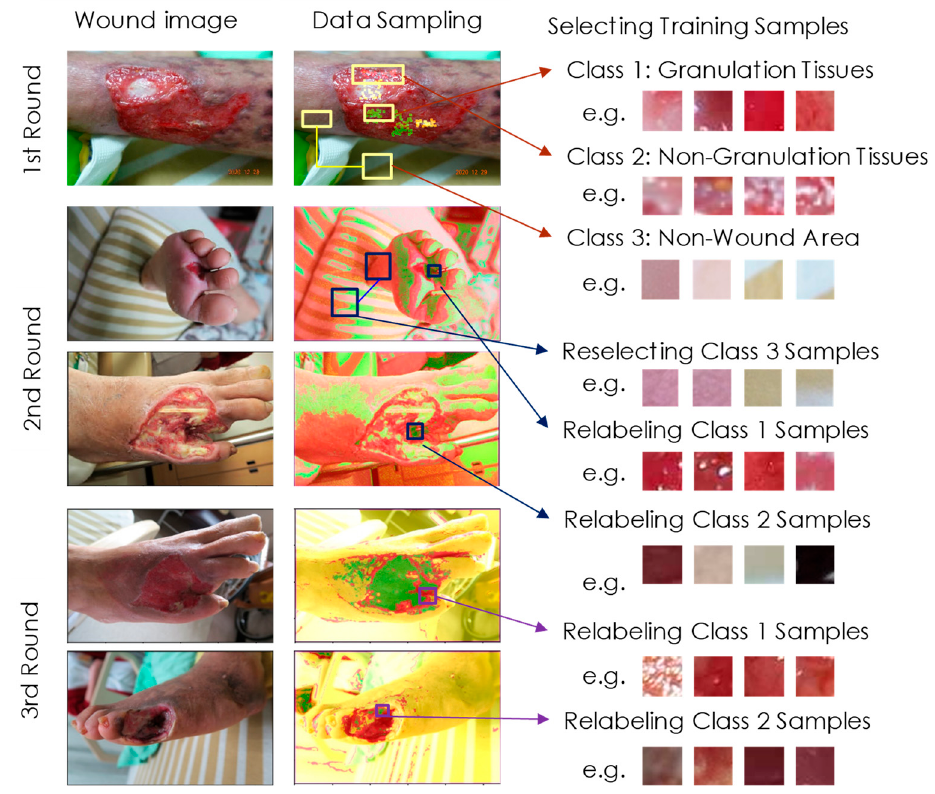
Figure 2. Three rounds of active learning. In the first round, we collected samples from three classes by drawing bounding boxes and generating 32 × 32 blocks for experts to label. We trained the model using the first set of images and applied it to detect images in the second set. When we colored the output classes with green, red, and yellow, respectively, misclassified samples could be easily relabeled and inserted into the dataset in the second round. We increased classes 1, 2, and 3 samples by 1933, 7327, and 211,397, respectively, resulting in more accurate detections before round 3. In the final round of resampling, we continued to collect misclassified samples from the third set of images. Finally, we used all samples in the dataset for model training. Table 1. Number of images and samples collected in the three rounds of active learning.